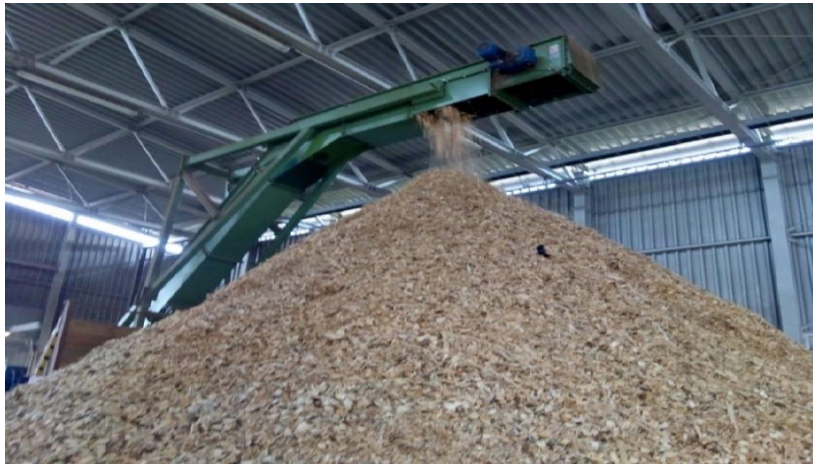
Figure 4. Chipper for biomass homogenization in Lębork (photo: B. Igliński). There are 22 biogas plants in operation in the Voivodeship, with a total capacity of 21,843 MW (data from the Energy Regulatory Office [78]; 20 biogas plants according to the Pomerania Spatial Planning Office [75]). According to the register of agricultural biogas producers, 10 agricultural biogas plants operate in the Pomerania Voivodeship (Table 5). Table 5. Characteristics of agricultural biogas plants in the Pomerania Voivodeship (author’s own study from: [75,78]). Power (MW) Efficiency (mln m 3 City Substrates Biogas/Year)